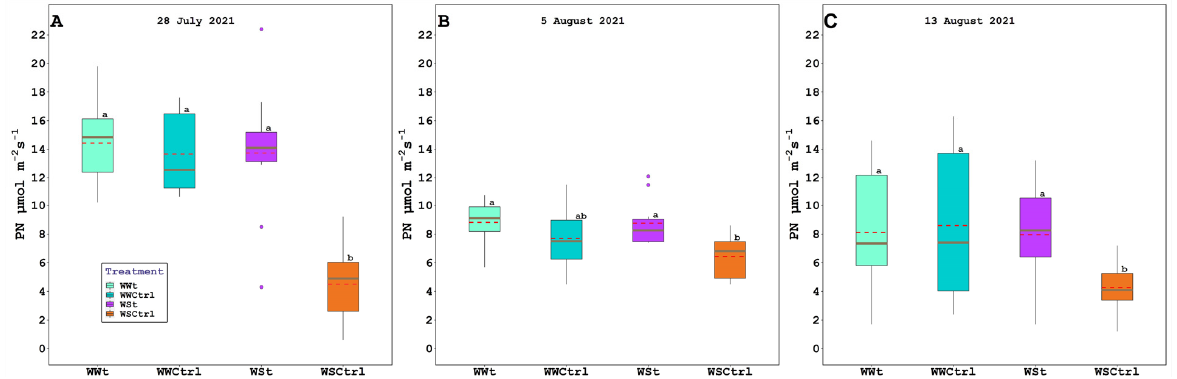
Figure 3. Leaf temperature (Tleaf; °C) in Vitis vinifera (Pinot Noir cv.) treated with Zeolite (t) and untreated plants (Ctrl), under two irrigation regimes (WW, well-watered; WS, water-stressed); ( A ). 28 July 2021, ( B ). 5 August 2021, and ( C ). 13 August 2021. The box bounds show the 25 and 75 percentiles, and the error bars the 90 and 10 percentiles. The black continuous and red discontinuous lines inside the boxes represent medians and means, respectively. Outliers are represented as color dots. Average values with the same letter in each figure indicate no significant differences between plots ( p < 0.05).